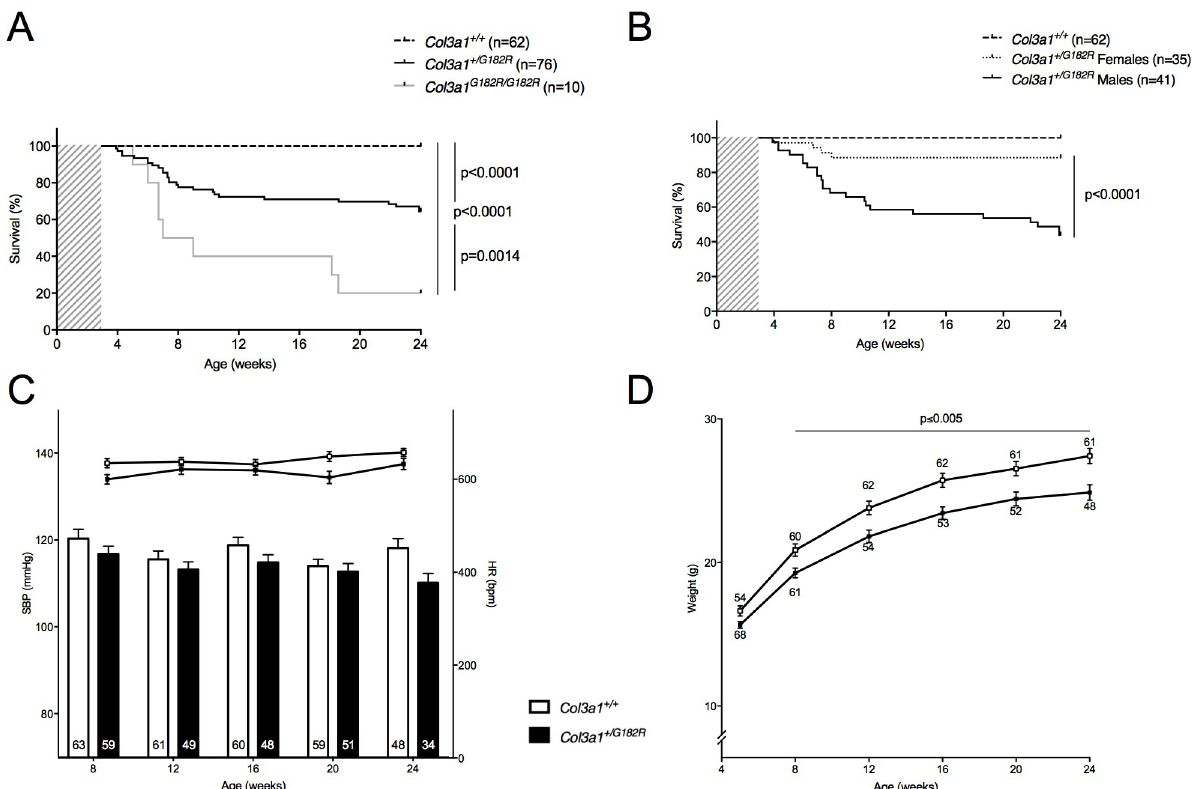
Fig 1. Survival rate and basal hemodynamic parameters of Col3a1 +/G182R mice. A Kaplan-Meier Survival curve for comparing col3a1 +/+ (n = 62) to Col3a1 +/G182R (n = 76) and to Col3a1 G182R/G182R (n = 10), which die from vascular rupture or dissection. Significant differences are calculated using Log-Rank (Mantel-Cox) analysis. B Kaplan-Meier Survival curve for comparing Col3a1 +/G182R males (n = 41) and Col3a1 +/G182R females (n = 35). Significant difference is calculated using Log-Rank (Mantel-Cox) analysis. C Graph represents basal systolic blood pressure (SBP; lower bars: left scale) and heart rate (HR; upper lines: right scale), measured between 8 and 24 weeks in the same Col3a1 +/+ and Col3a1 +/G182R mice represented in A using a tail-cuff method. Numbers within the bars indicate the number of living mice studied at each time of measurement. SBP was comparable between groups of mice (p > 0.05 at each time of measurement: 8, 12, 16 and 20, except for 24 weeks, student t-test) and HR was lower in Col3a1 +/ G182R (p < 0.05 at 8 and 20 weeks, student t-test). D Graph represents weight measured between 5 and 24 weeks in the same Col3a1 +/+ and Col3a1 +/ G182R mice represented in A. Weight was significantly different in Col3a1 +/+ and Col3a1 +/G182R mice (p = 0.020 at 5 weeks and p < 0.005 between 8 and 24 weeks, student t-test). Data are expressed as the mean ±